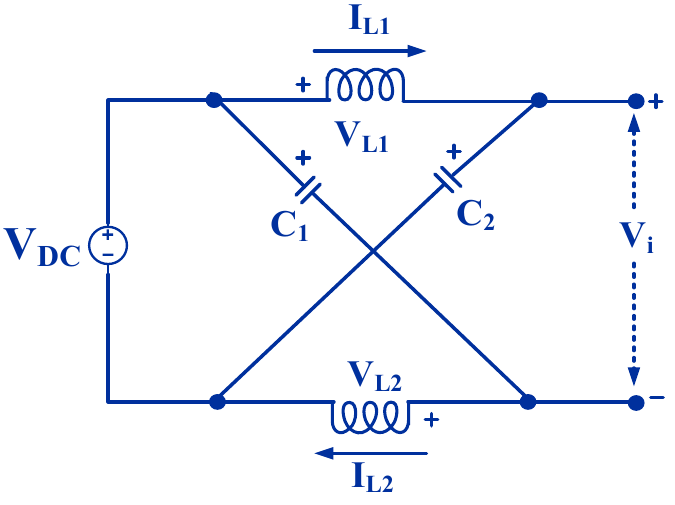
Figure 13. Equivalent Circuit of the ZSI in traditional zero states.